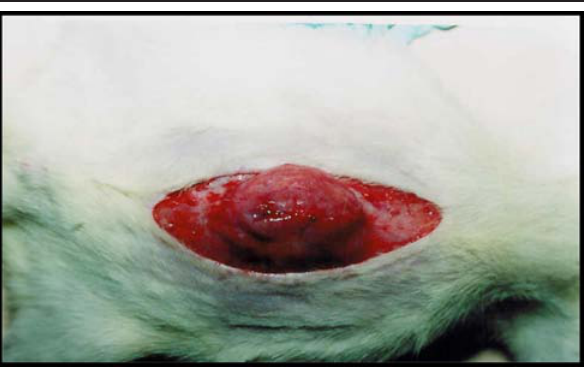
FIGURE 1 - Skin opening showing incisional